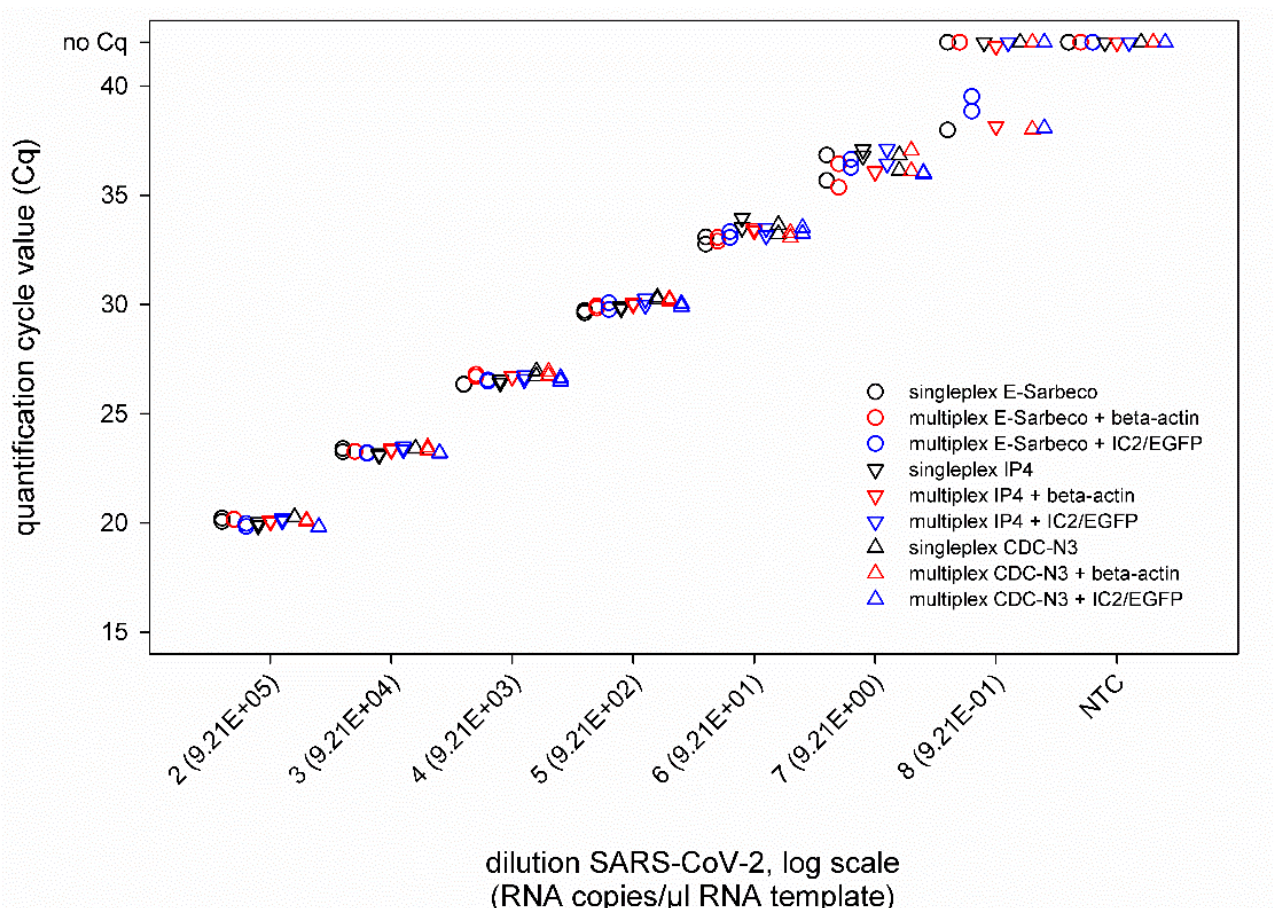
Figure 3. Results of the SARS-CoV-2 real-time RT-PCRs E-Sarbeco, IP4 and CDC-N3 performed either individually (black) or in a duplex reaction with an internal control assay based on the housekeeping gene beta-actin (red) or a heterologous control (IC2/EGFP, blue). All samples were tested in duplicate. NTC—no template control (=RNase free water).